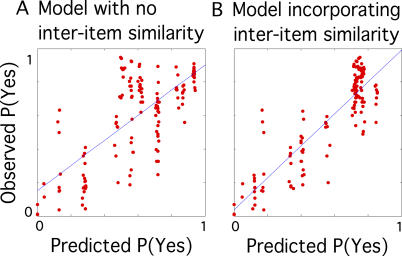
Model Fits for NEMoModel fits for NEMo are much better for versions including inter-item homogeneity (four-parameter model in [B]), than for identical models that do not include inter-item homogeneity (three-parameter model in [A]). Line indicates best fit to the data.